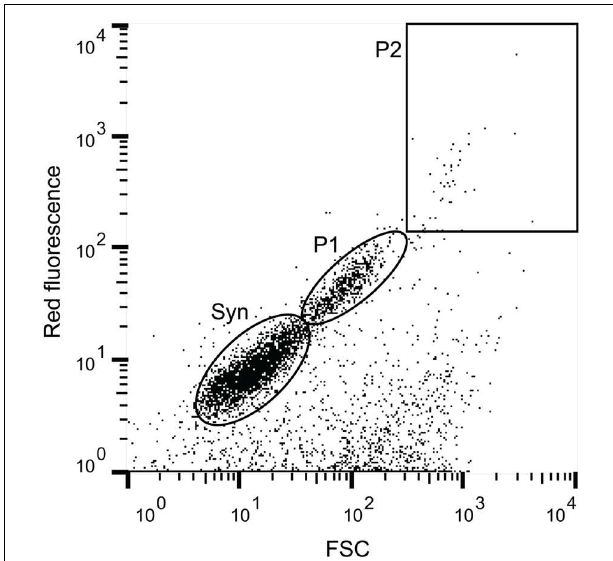
FIGURE 1 | Example of a flow cytogram with the cell populations that were targeted in this study. Red fluorescence was used as a proxy for chlorophyll a content and forward scatter (FSC) as a proxy for size. The indicated cell populations are Syn ( Synechococcus ) as defined by phycoerythrin content (Orange fluorescence), and two size fractions of photosynthetic picoeukaryotes, small (P1, ∼ < 3 µ m beads) and large (P2, ∼ > 3 µ m